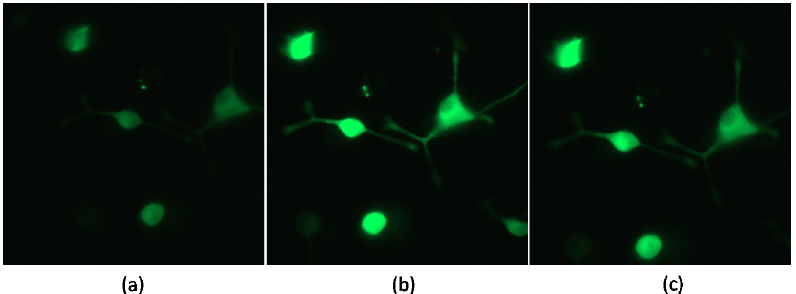
Figure 3. Time lapse of calcium ‐ mediated fluorescence following KCl stimulation. Images depict the fluorescence in GCaMP5 transfected PC ‐ 12 cells pre ‐ treated with 0.1% DMSO Vehicle. Images were taken ( a ) before, ( b ) immediately after, and ( c ) 20 s post ‐ KCl injection. Final KCl concentration = 50 mM.